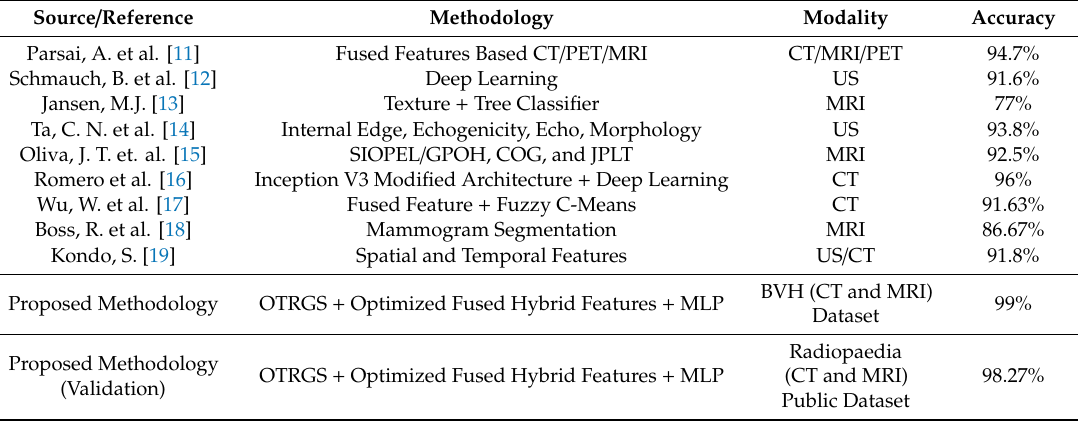
Table 8. Comparison table of the proposed and current state-of-the-art techniques.